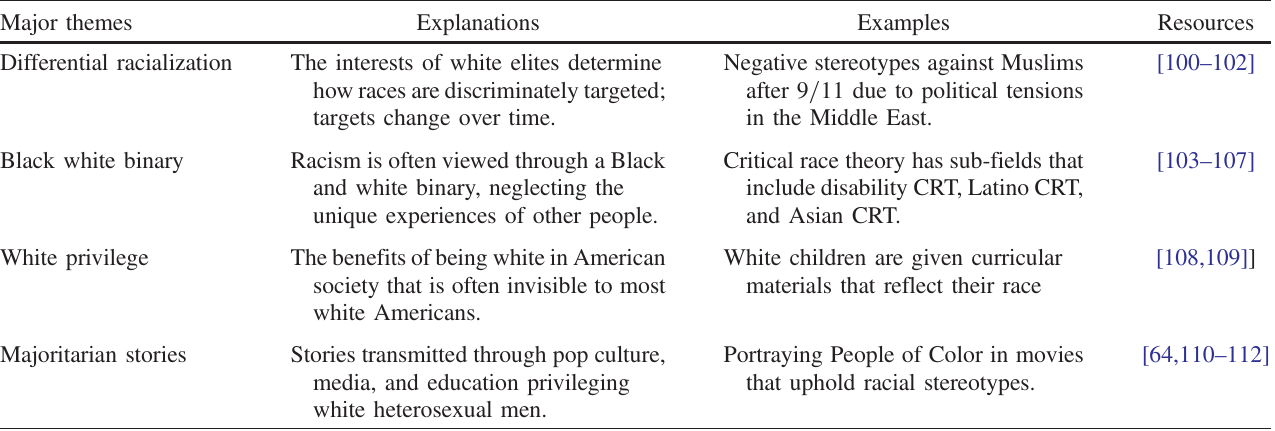
TABLE III. Summary of other major ideas of critical race